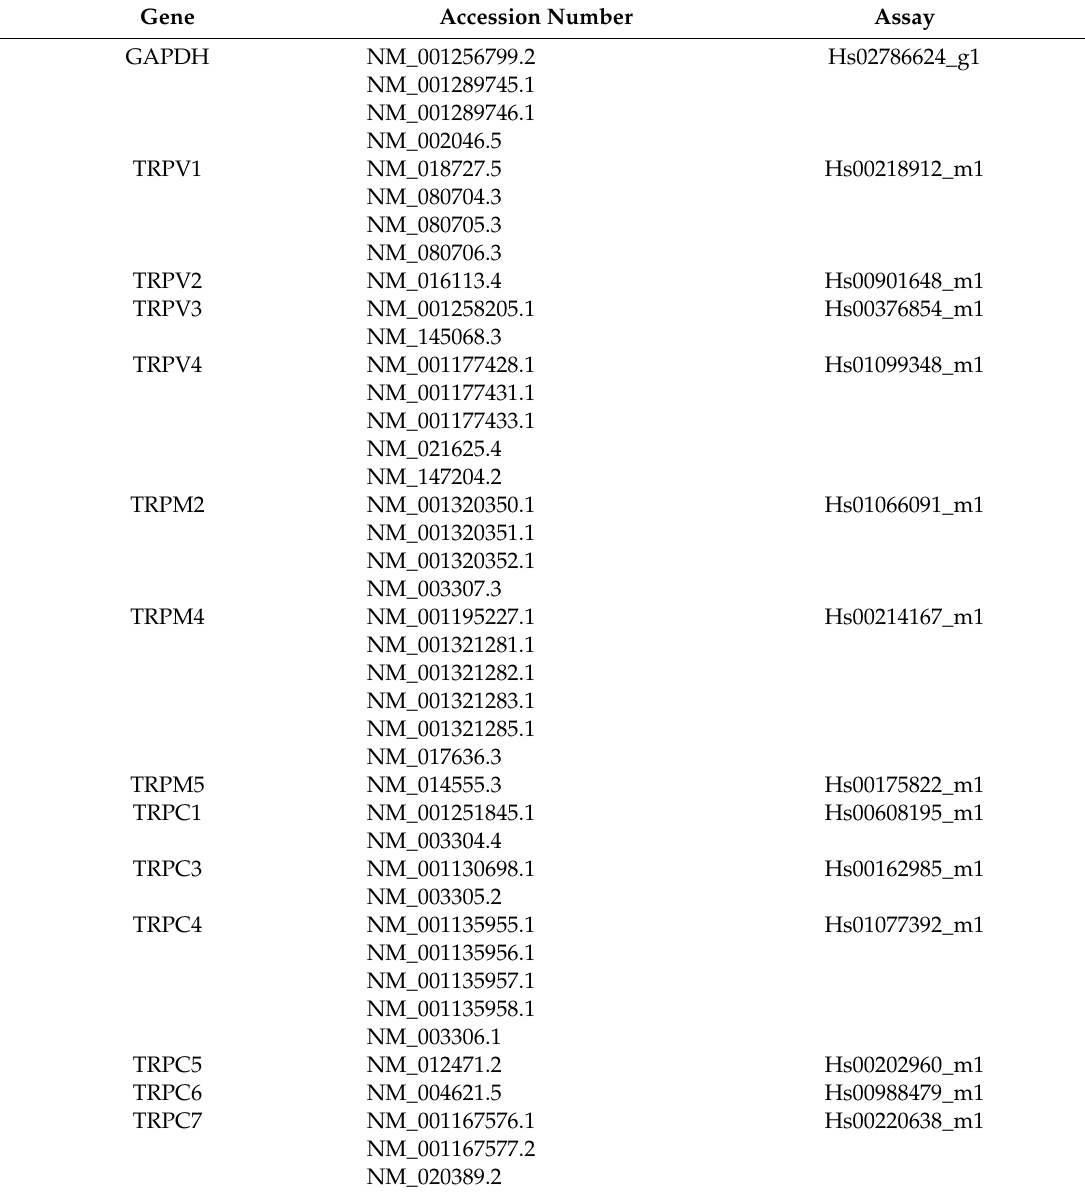
Table 2. Details of TaqMan probes and primers used in this